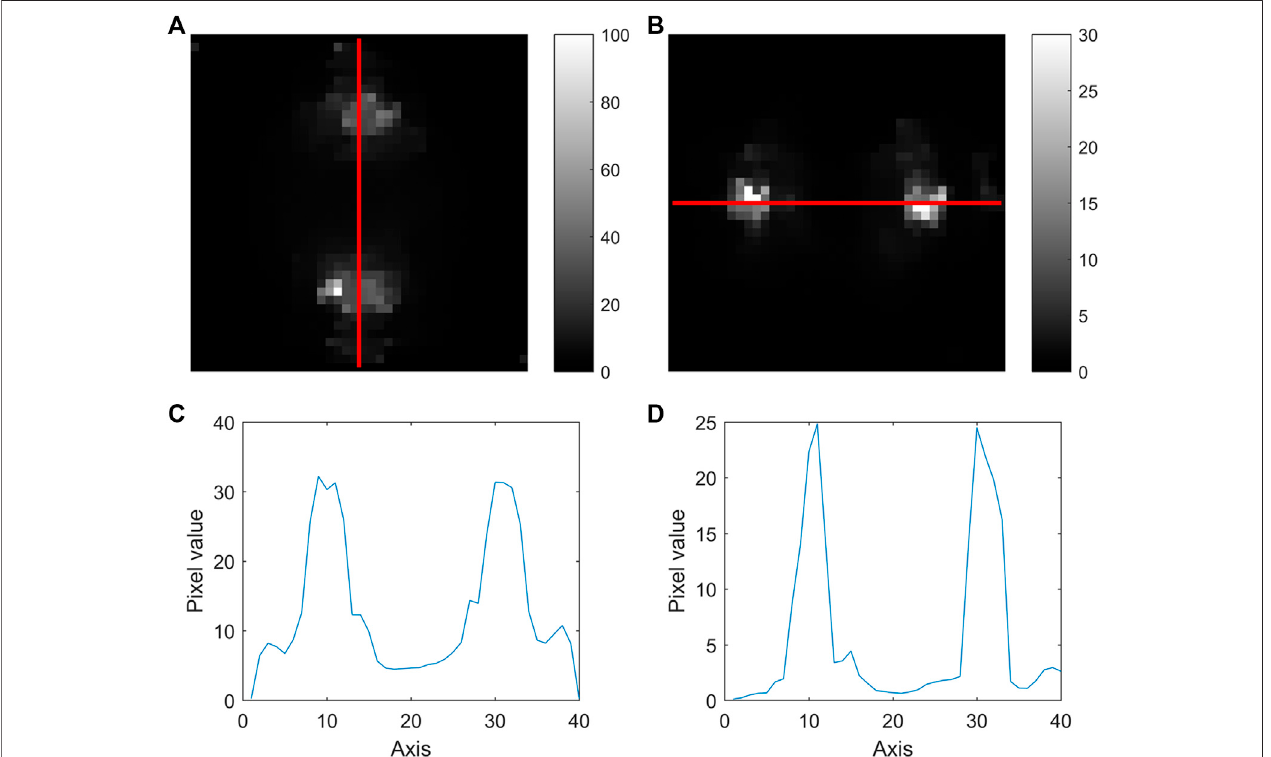
FIGURE 11 | Reconstruction results: (A) I ([0 100 mg/ml]) and (B) Gd ([0 30 mg/ml]); and line pro fi les of (C) I and (D) Gd.